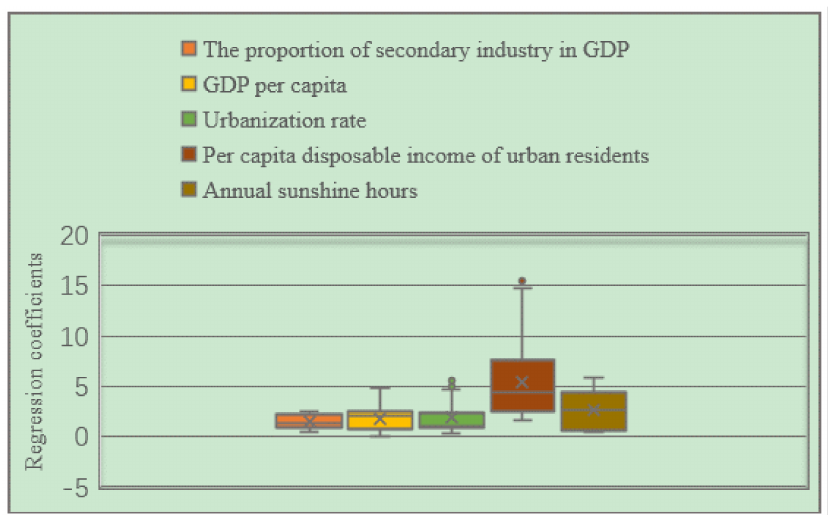
Figure 16. Box plot of GWR model regression coefficient distribution of EPC in the three major urban agglomerations of the YREB in 1999.